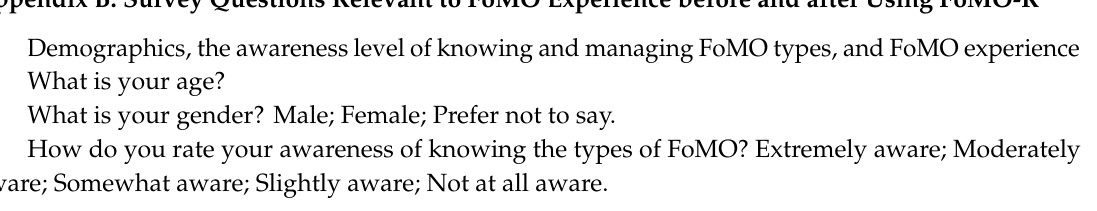
Booklet 1: Self-rating booklet, Booklet 2: List of FoMO countermeasures, Booklet 3: Relapse prevention, Booklet 4: Empowered refusal and